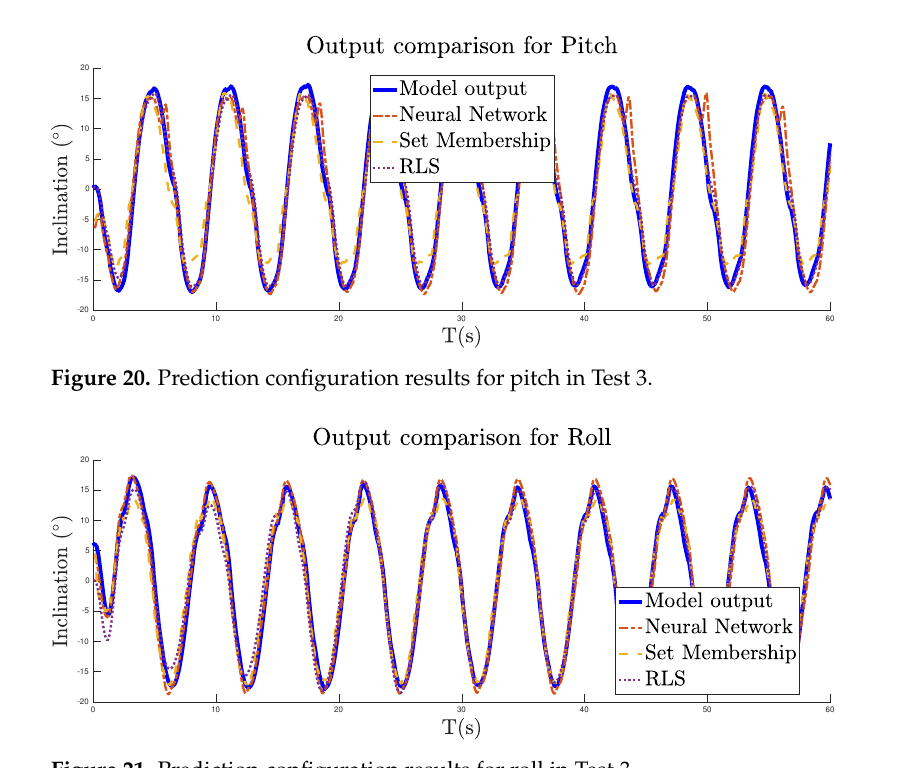
Figure 21. Prediction configuration results for roll in Test 3.